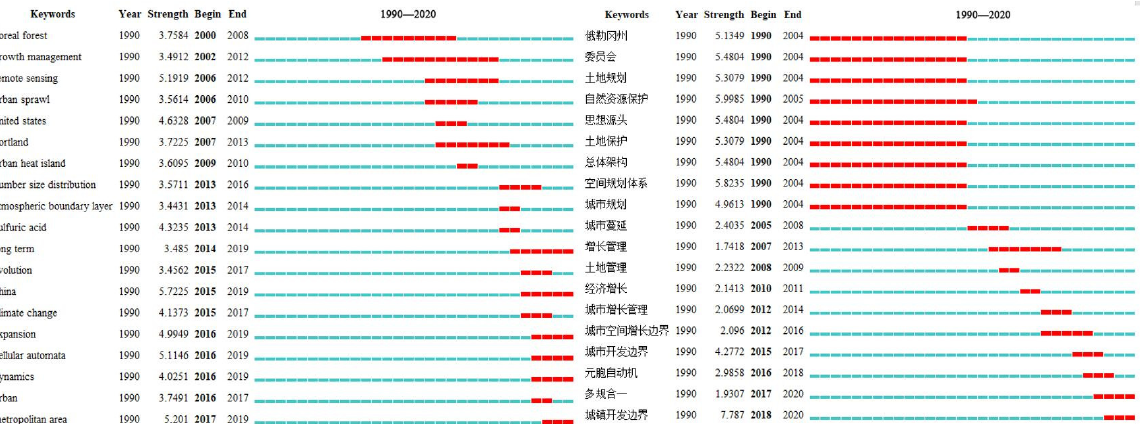
Figure 4. Keyword emergence diagram of urban growth boundary research in foreign languages ( left ) and Chinese ( right ). (Please refer to Appendix A Table A1 for the translation of Chinese words)